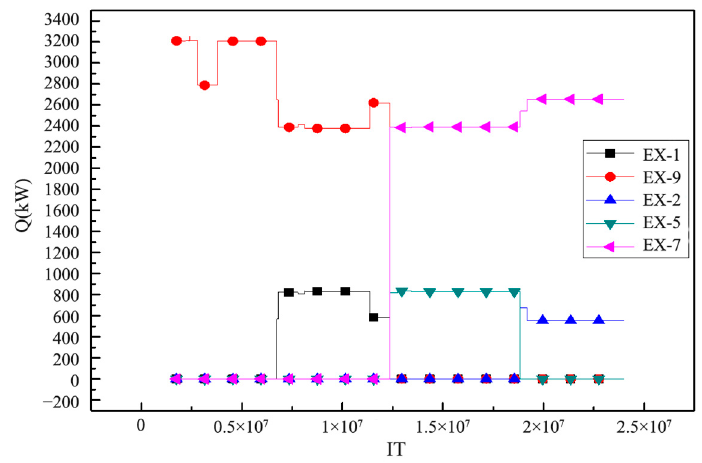
Figure 9. Heat load change of the heat exchanger on the stream without a utility exchanger.